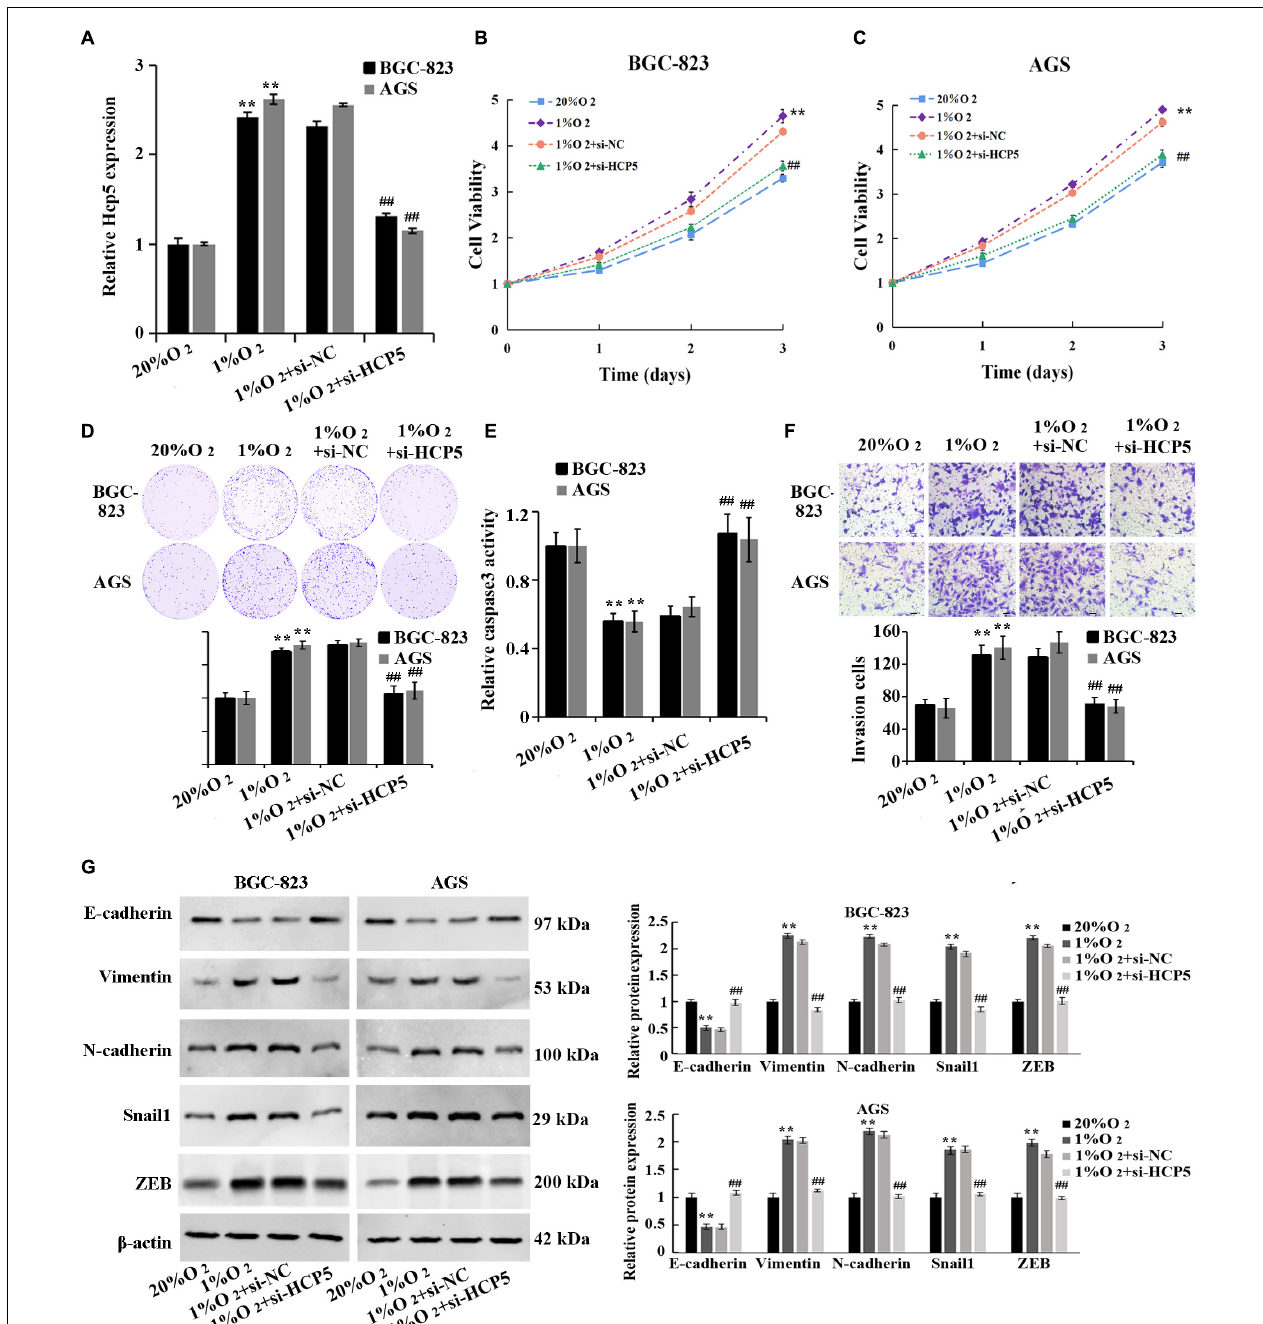
FIGURE 2 | Inhibition of hypoxia-induced proliferation, invasion, and EMT process in gastric cancer cells by downregulation of HCP5. (A) qRT-PCR-based detection of transfection efficiency of HCP5 siRNA; (B,C) MTT-based detection of cell proliferation. (D) Colony formation assay-based detection of cell viability. (E) Caspase-3 activity in each group. (F) Transwell assay-based detection of cell invasion. (G) Western blotting-based detection of expression of E-cadherin, vimentin, N-cadherin, Snail1, and ZEB. ** p < 0.01 vs. 20% O 2 group; ## p < 0.01 vs. 1% O 2 + si-NC